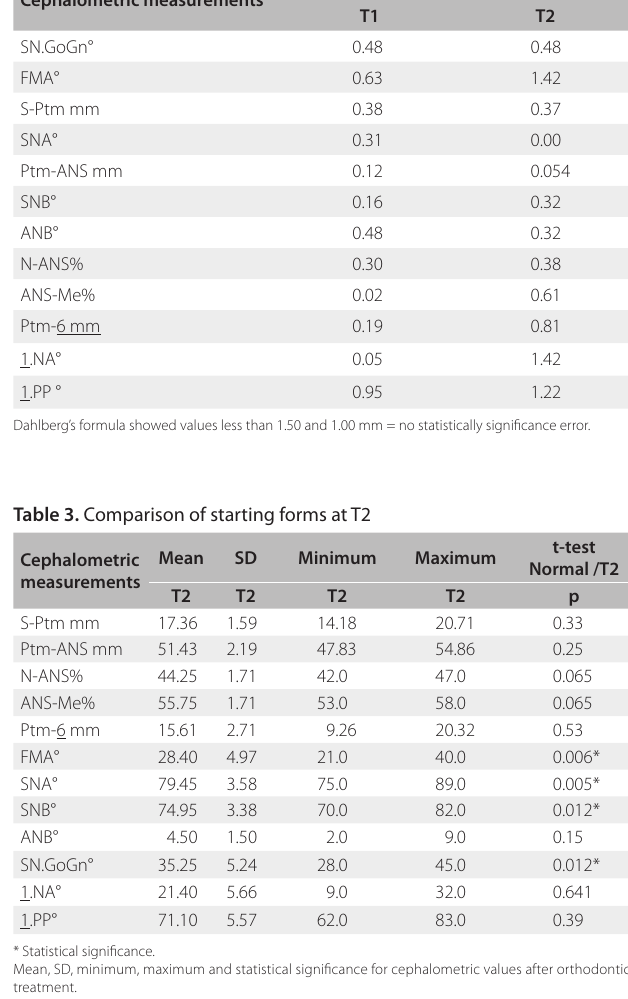
Table 1. Dahlberg’s formula Cephalometric measurements